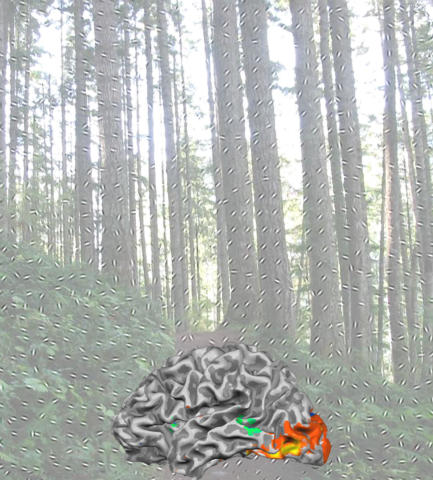
The human brain learns to detect the contours of target objects in cluttered scenes by recruiting early and higher centers of visual analysis